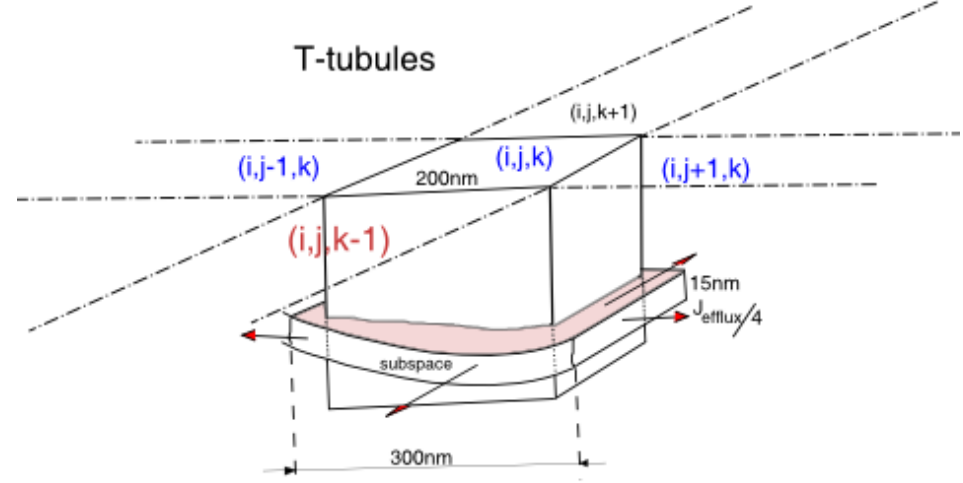
Figure 3. The schematic diagram shows a grid point as a cube of size 200 nm on each dimension in the 3-dimensional space. In this cube, we put a single dyad. Assuming that the width of the dyad is 300 nm, we model the efflux of calcium flowing into 4 adjacent grid points, and it is equally split into 4 parts. The grid location is given by the coordinate